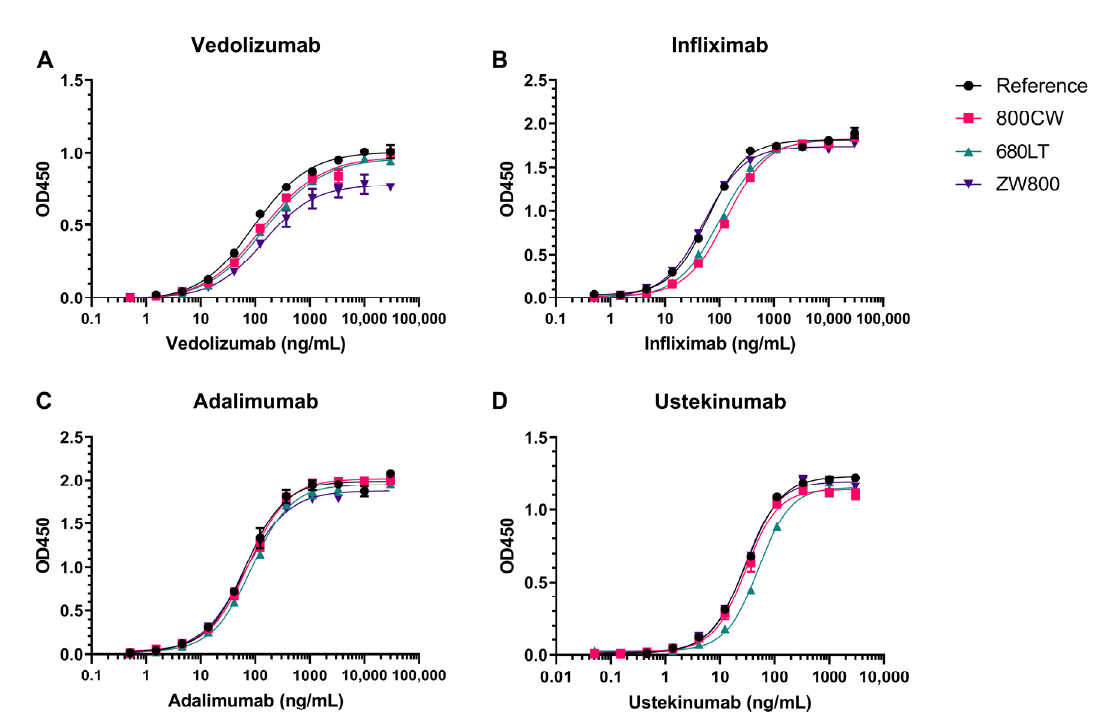
Figure 6. Indirect enzyme-linked immunosorbent assay (ELISA) results for the determination of the affinity of vedolizumab ( A ), infliximab ( B ), adalimumab ( C ) and ustekinumab ( D ) conjugates to their target. Each panel ( A – D ) shows overlayed results of one antibody’s reference standard and conjugates of that antibody to 3 different dyes. Serially diluted binding curves were compared to an unmodified reference on the same plate. Affinity was calculated as the ratio between the EC50 values for reference and sample curves. Comparable binding affinities were shown for all conjugates except infliximab- 800CW, infliximab-680LT and ustekinumab-680LT.